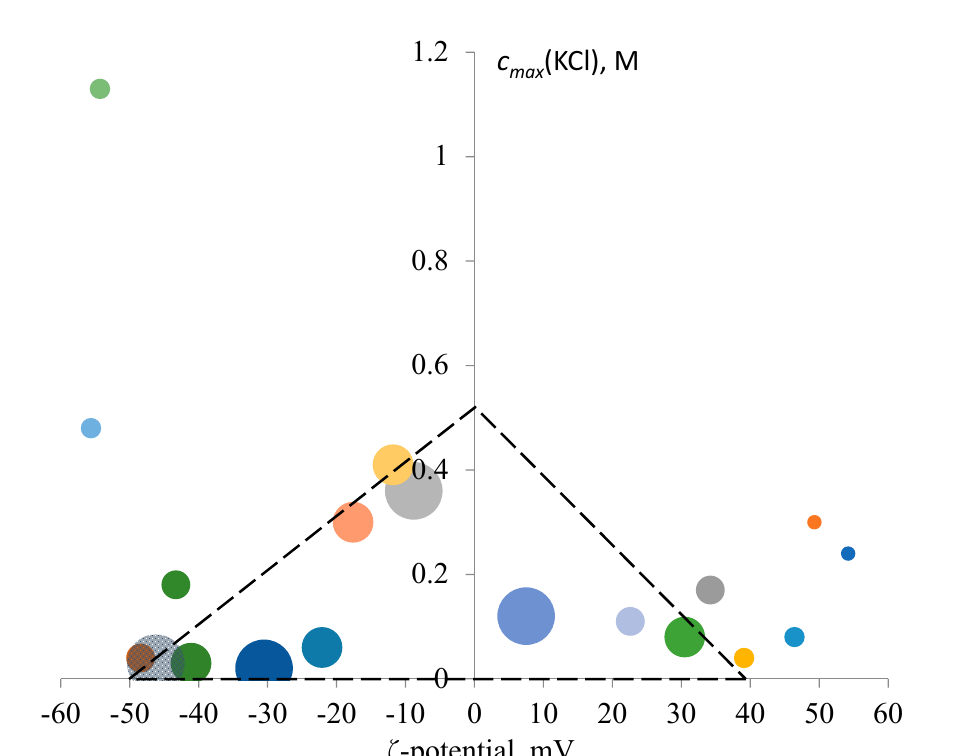
Figure 4. Effects of the ζ -potential and the silver NP resistance to KCl, c max (KCl), on the NP toxicity to yeast cells. The size of each bubble is proportional to the MIC value of the corresponding dispersion; the smaller the size, the higher the biological activity of the dispersion.